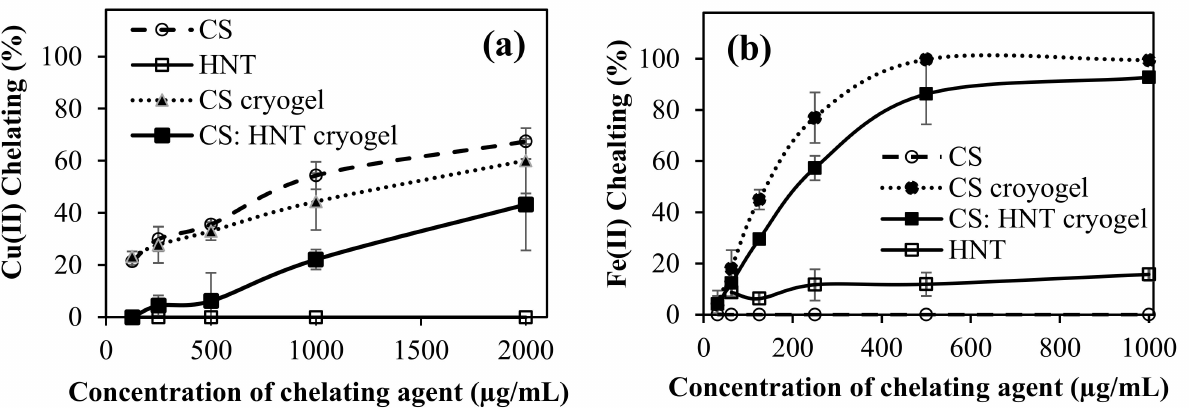
Figure 7. ( a ) Cu(II), and ( b ) Fe(II) chelating capability of CS, HNT, CS cryogel and CS: HNT